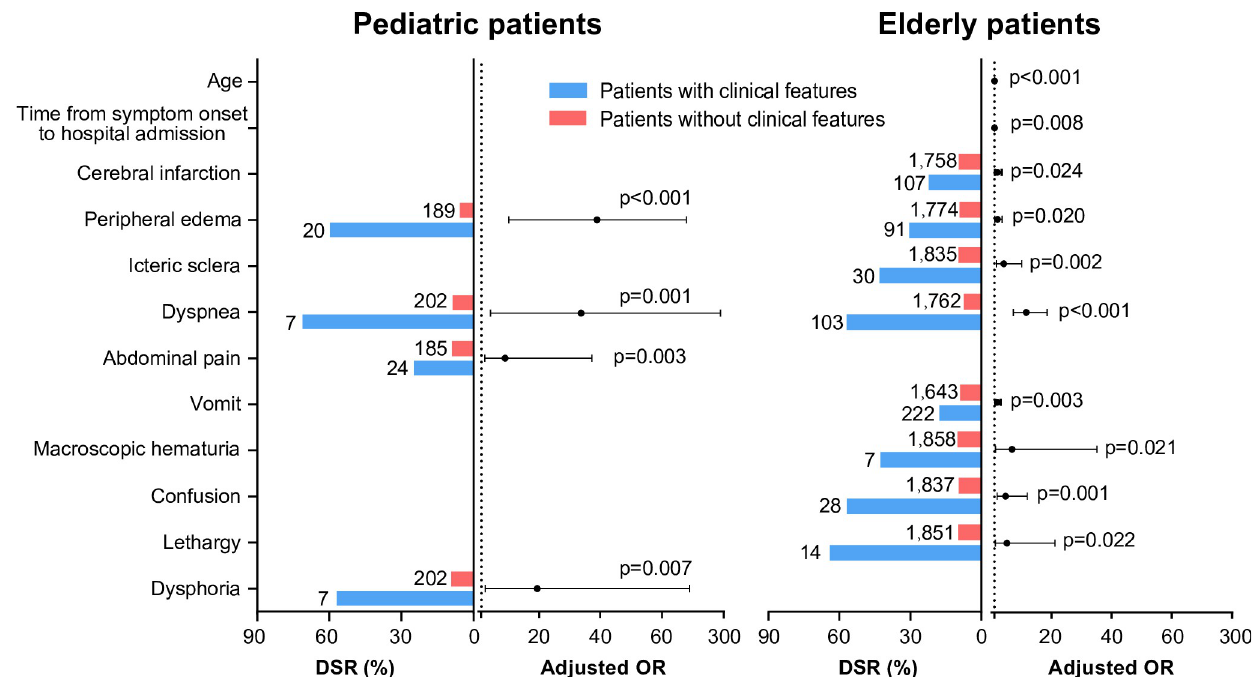
Fig 2. The major clinical symptoms and signs in association with disease severity rates in patients with scrub typhus. The number of patients with or without each of clinical symptoms/signs is shown at the left of the columns, based on which the disease severity rate was calculated and marked by the length of the column. The black points indicate the adjusted ORs for disease severity by using multivariate logistic regression model; the black error bars indicate the 95% confidence intervals. The dotted line indicates an adjusted OR of 1. DSR, disease severity rate; OR, odds ratio. Pediatric patients, age 0–14 years; elderly patients, age � 60